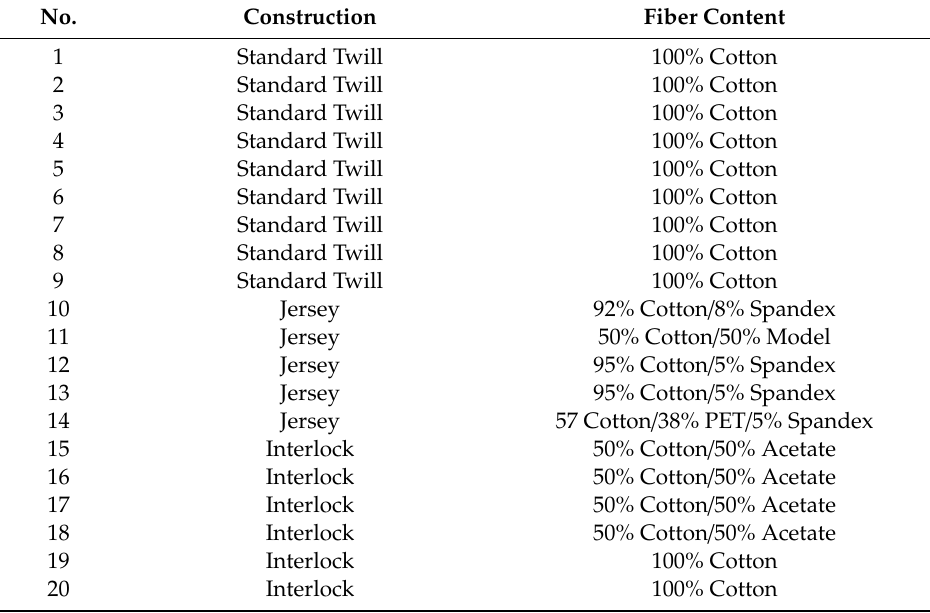
Table 4. Specs of the fabric